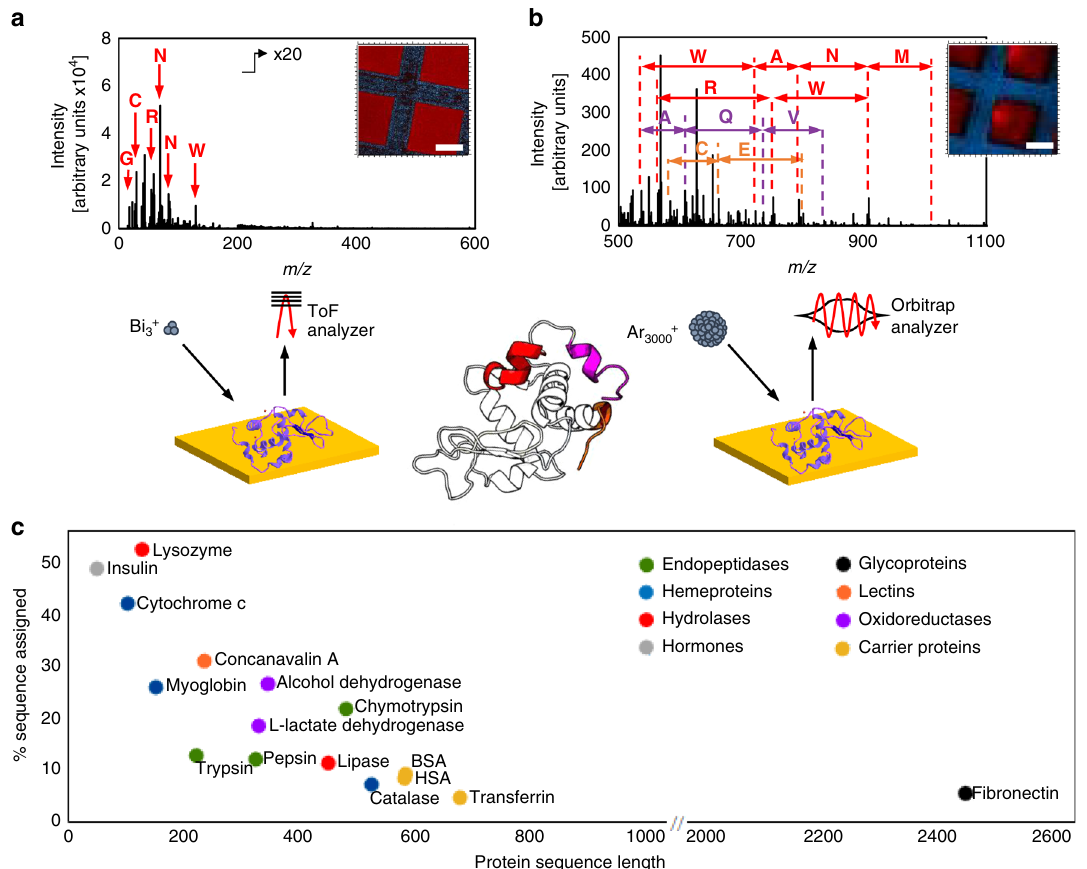
Fig. 1 Comparison of Bi 3 + primary ion beam ToF-SIMS and Ar 3000 + primary ion beam 3D OrbiSIMS analysis of lysozyme. a In the positive ion secondary mass spectrum obtained using ToF-SIMS, only single amino acid fragments can be identi fi ed. b In the GCIB 3D OrbiSIMS data, protein fragments larger than single amino acids are generated due to the GCIB bombardment. Amino acid neutral losses, W-tryptophan, A-alanine, N-asparagine, M- methionine, R-arginine, Q-glutamine, T-tyrosine and V-valine can be assigned due to the high mass-resolving power and mass accuracy of the Orbitrap TM analyser. The amino acid sequences are highlighted in the lysozyme structure, exported from PDB entry1AZF 38 . In the associated LMIG ToF-SIMS and GCIB 3D OrbiSIMS images of lysozyme fi lm under a gold grid, blue represents the gold signal and red represents a sum of ( a ) amino acid fragments listed in Supplementary Table 1 and ( b ) assigned peptide fragments listed in Supplementary Fig. 6. The scale bars represent 50 μ m. c Sixteen proteins of different biological functions were analysed. From 5% (transferrin) to 53% (lysozyme) sequence coverage was achieved for a range of sizes from 51 to 2446 amino acids. Table 1 Examples of functional sites detected in the 16 analysed proteins.